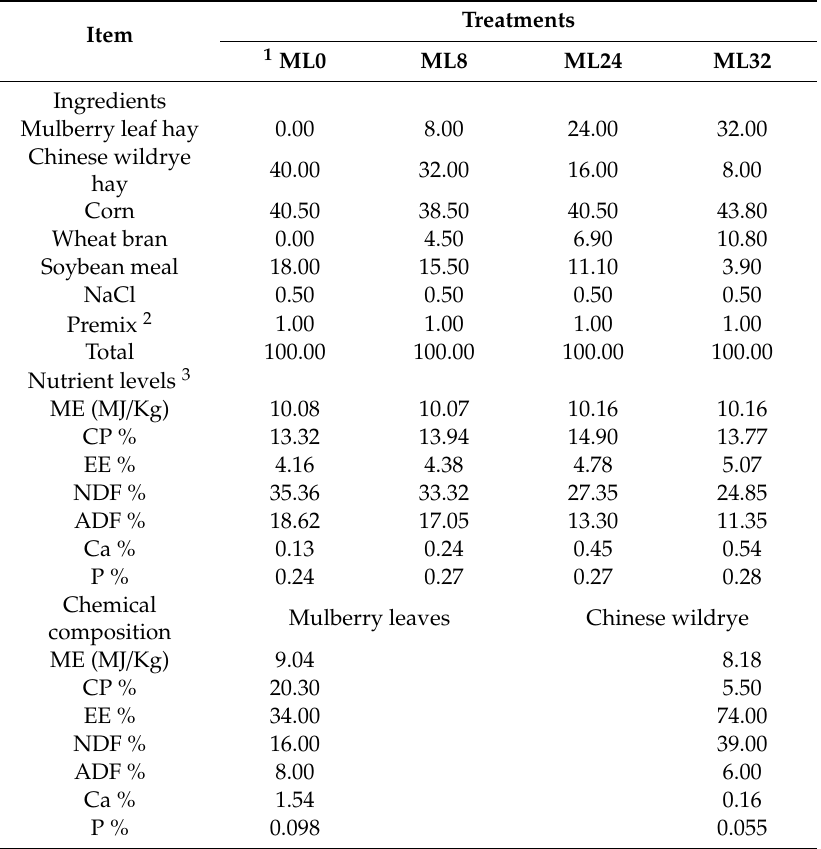
Table 1. Dietary composition and nutrient level in the experimental treatments of